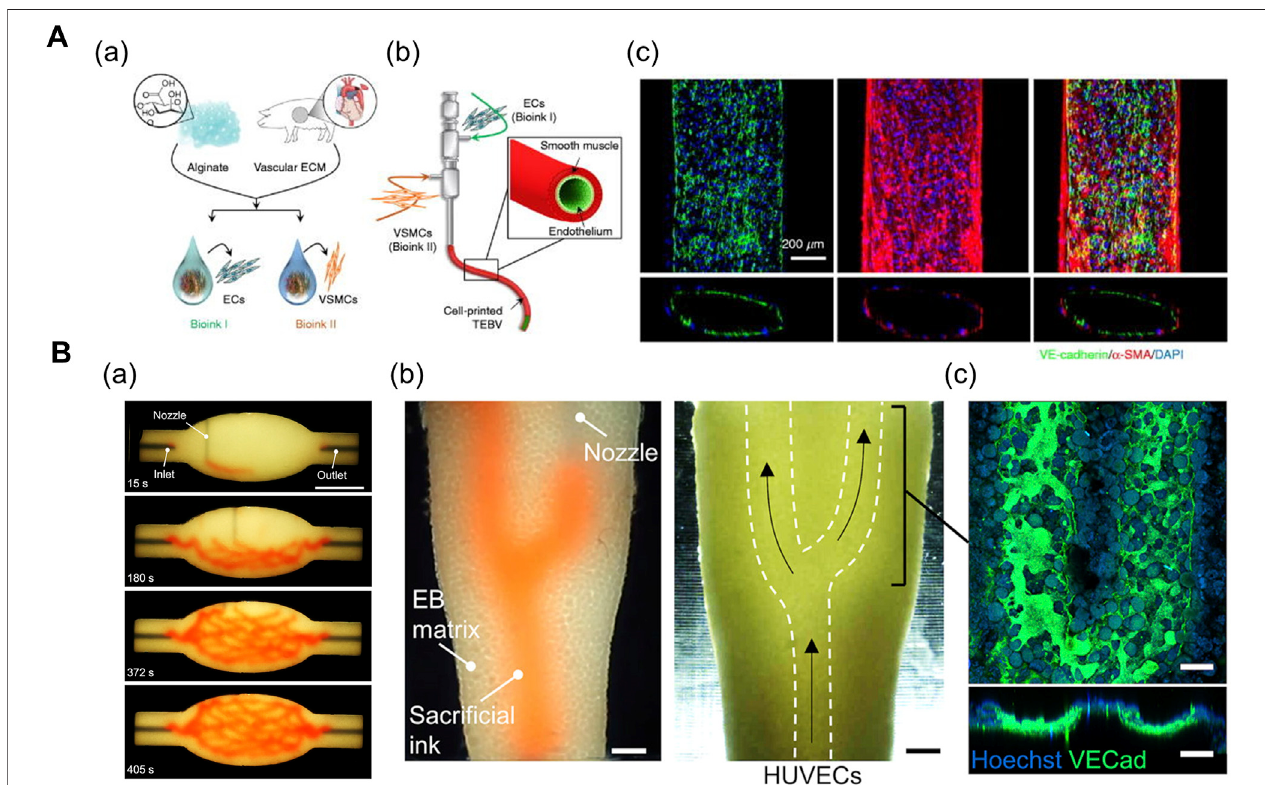
FIGURE 3 | (A) Coaxial printing method. (a) Formulation of vascular tissue-derived bioinks for promoting vascular maturation. (b) Schematic of triple-coaxial cell printing method yielding compartmentalized vascular structure. (c) Confocal image of printed vascular structure with combined expression of endothelial and muscular markers. Reprinted with permission from (Gao et al., 2019). (B) Direct ink-writing method. (a) Sequence of branched and hierarchical vascular network fabricated with directink-writingmethod.(b)PerfusionofECsintoevacuatedchannel(white-dashed lines).(c)ExpressionofVE-cadherinafter20 hofperfusiondisplaysformation of endothelium monolayer. Reprinted with permission from (Skylar-Scott et al.,